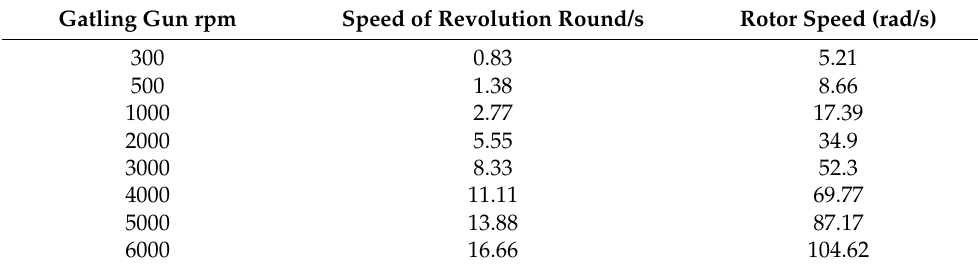
Table 2. Gatling gun rotation rate.